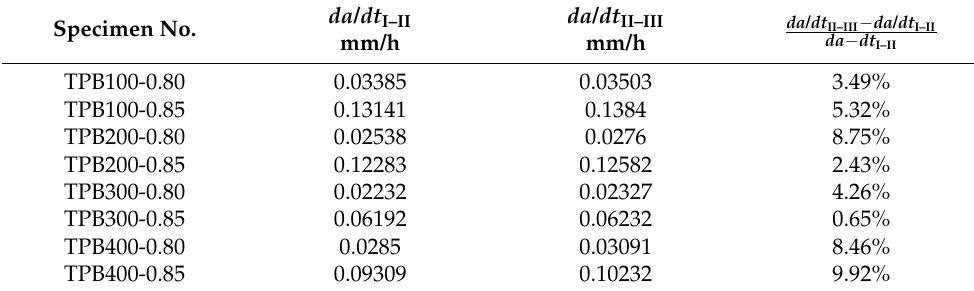
Table 4. Fitting